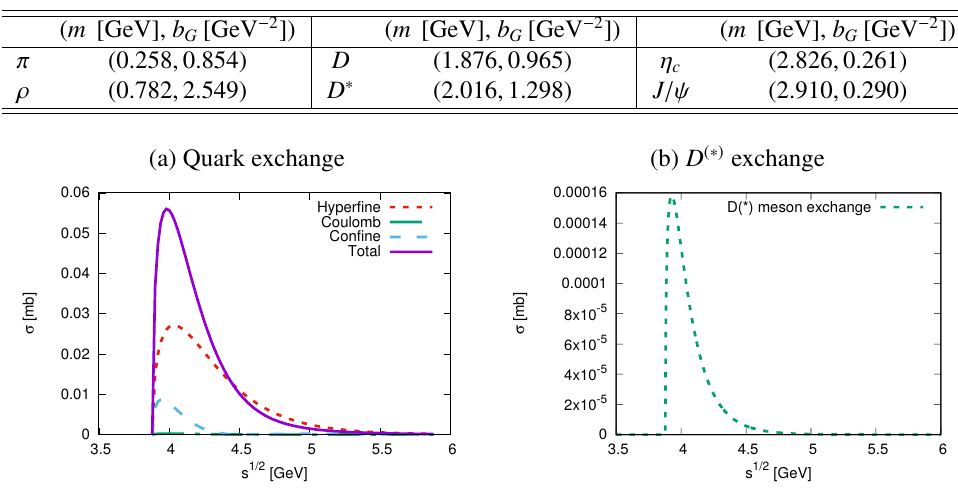
Figure 2. The cross section of the π J /ψ − D ¯ D ∗ transition by (a) the quark exchange model and (b) D ( ∗ ) exchange model. In (a), the solid line shows the cross section including all terms, spin-spin (hyperfine), coulomb, and confinement, while the short-dashed line is only for the spin-spin (hyperfine) term, the dashed-dot for coulomb term, and the long-dashed line for the confinement term